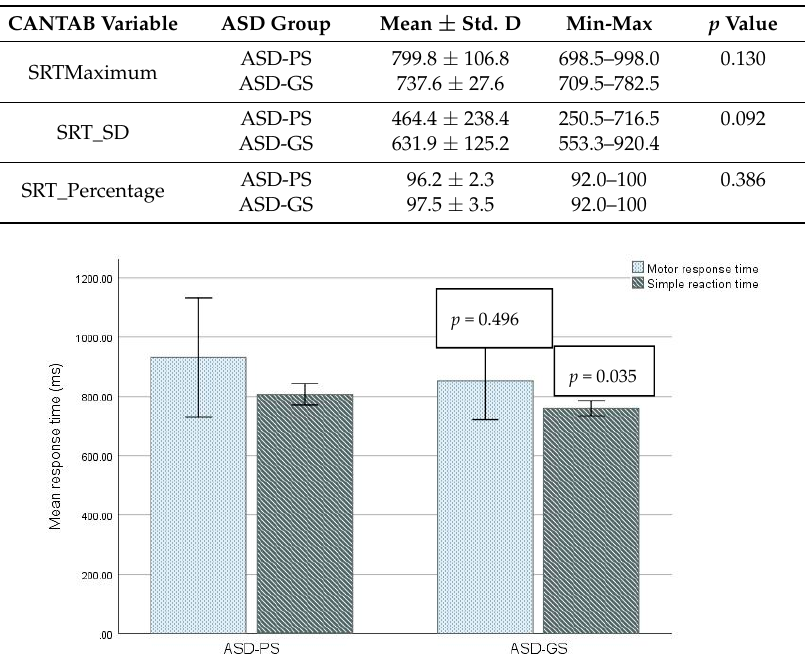
Figure 1. Comparison of cognitive function through response time in motor screening task and simple reaction time (ms) task among ASD poor sleepers (ASD-PS), ASD good sleepers (ASD-GS). The bars showed mean ± Std. D data.